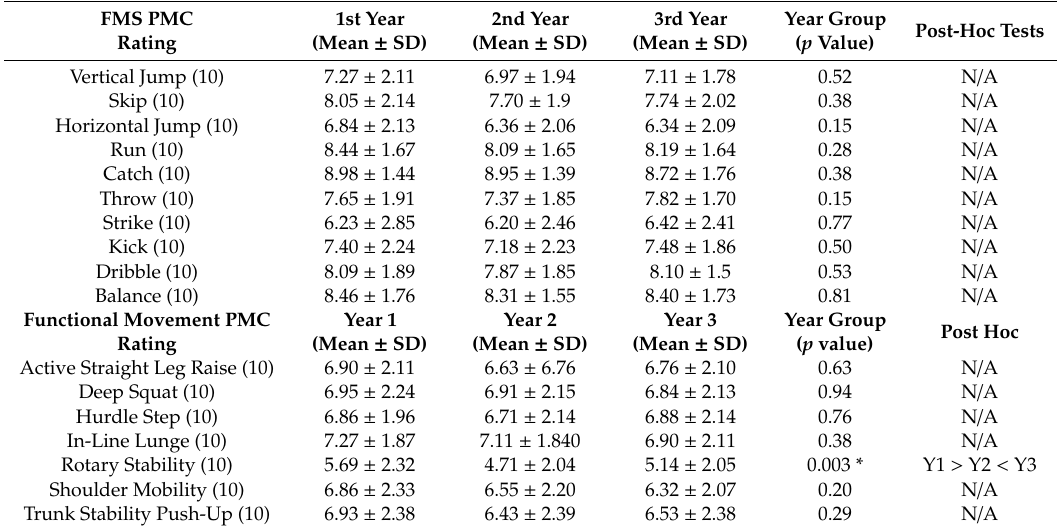
Table 2. Perceived motor competence (PMC) of the 10 FMS and 7 functional movements by year